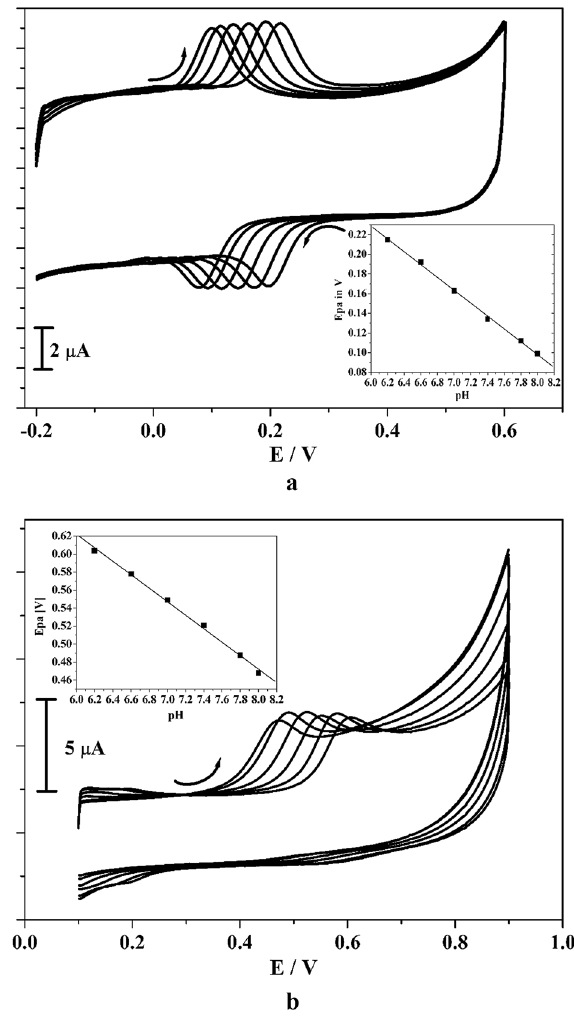
Figure 4. ( a ) CVs curve for 10 µM CC at poly (CBBG)/MCPE in the occurrence of altered pH and insert figure is plot of Epa versus pH. ( b ) CVs for 10 µM RS at poly (CBBG)/MCPE in presence of varied pH and inset figure is graph of Epa against